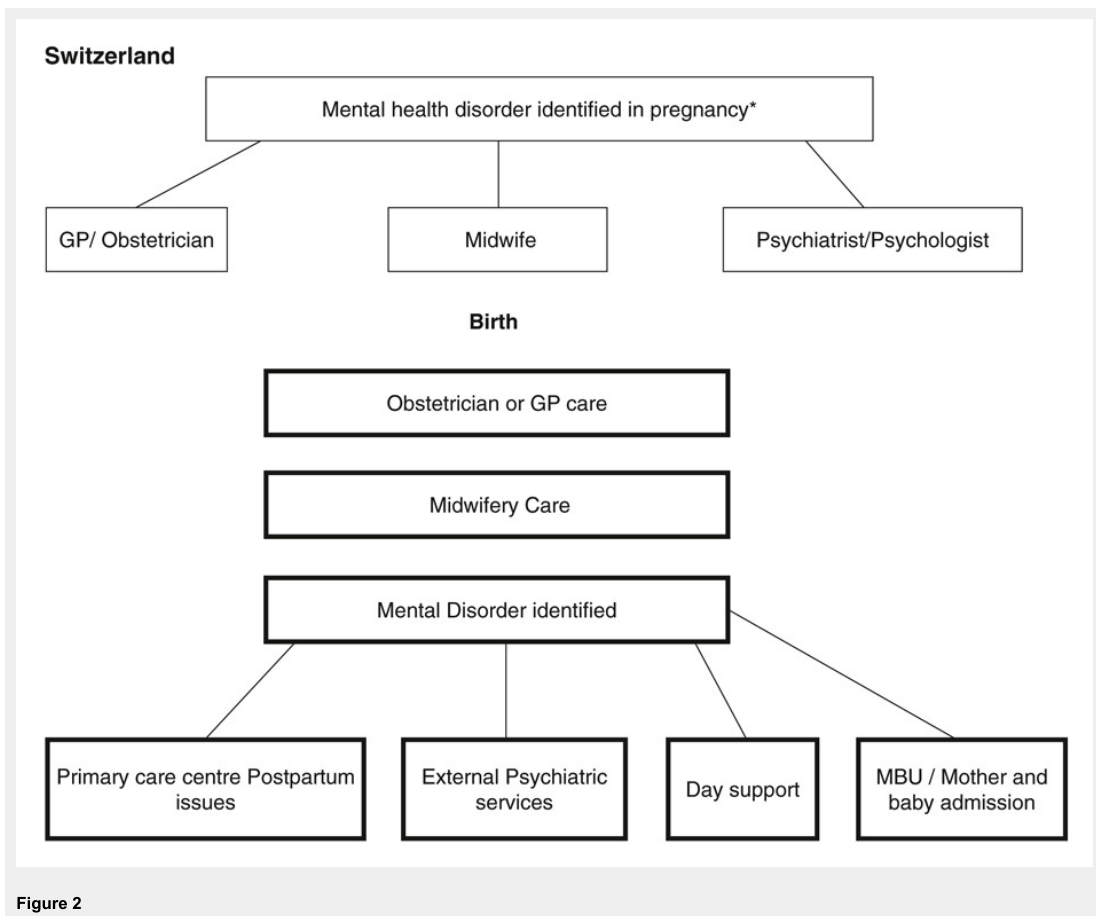
Care pathways offered to postpartum women with mental health disorders in Switzerland. *Treatment option is chosen by the patient that is free to access any health